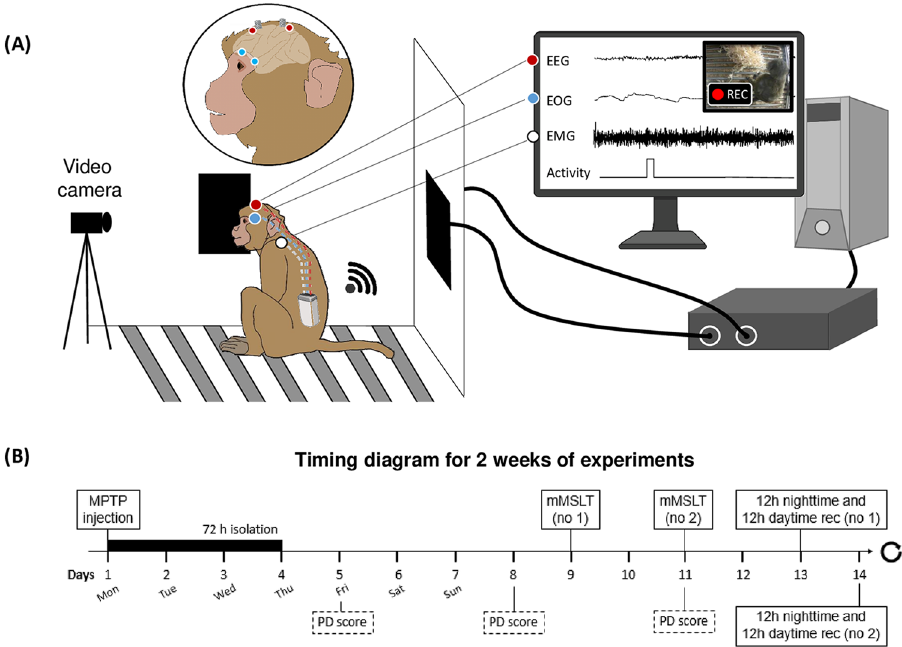
Figure 5. Experimental design. ( A ) Schematic representation of the polysomnographic setup for an implanted animal with the recordings of the brain activity (EEG, in red), the ocular activity (EOG, in blue) and the muscle activity (EMG, in white). Two cage-mounted receivers (black squares) are connected to a data exchange matrix, connected to a computer for data storage and off-line analysis. All recordings are synchronized with a video system. ( B ) Timing diagram for 2 weeks of typical